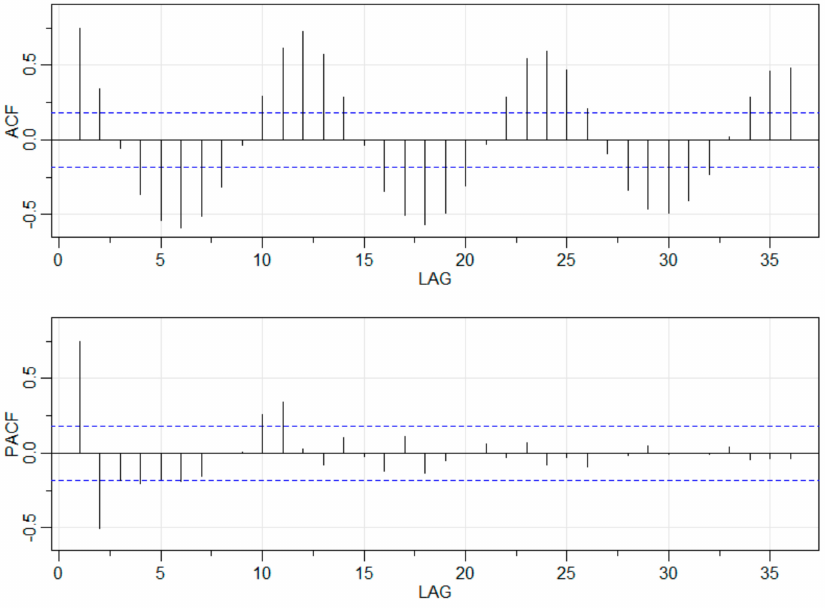
Figure 7. The ACF and PACF for monthly streamflow